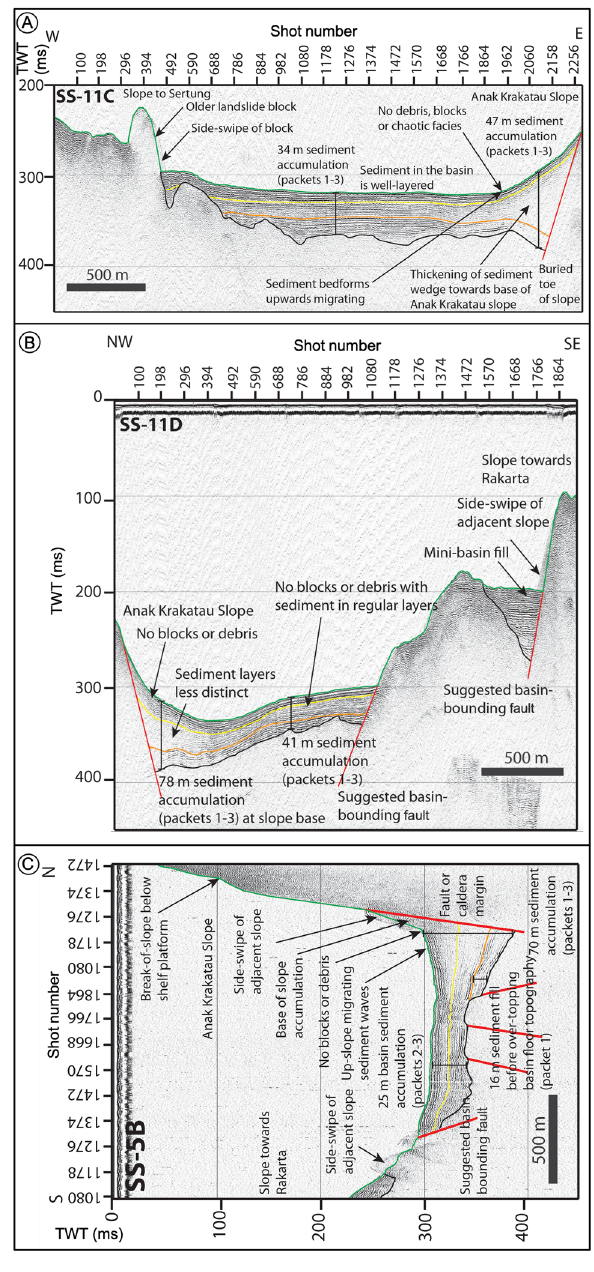
Fig. 5 Seismic re fl ection SPARKER pro fi les across the Krakatau caldera basin collected in 2017, before the fl ank collapse, showing the simple basin geometry and lack of landslide debris at the surface. Seismic re fl ection pro fi les SS-11C ( A ), SS-11D ( B ), and SS-5B ( C ) show 25 – 42 m (average 34 m) deposition between 1883 and 1990 within the caldera basin within three regular packages. There is no evidence of mass movements apart from minor, old, buried debris fl ows (represented by thin-bedded acoustically chaotic facies). Sediments likely from Anak Krakatau initially onlap basement caldera faults and in fi ll irregularities in the basement topography. Basin stratigraphy above an initial sediment package is represented by horizontal planar re fl uncertain, but a minimum (shallow) and maximum (deeper- seated) failure scenario can be constrained (Supplementary 12) and compared with the independently derived deposit volume.